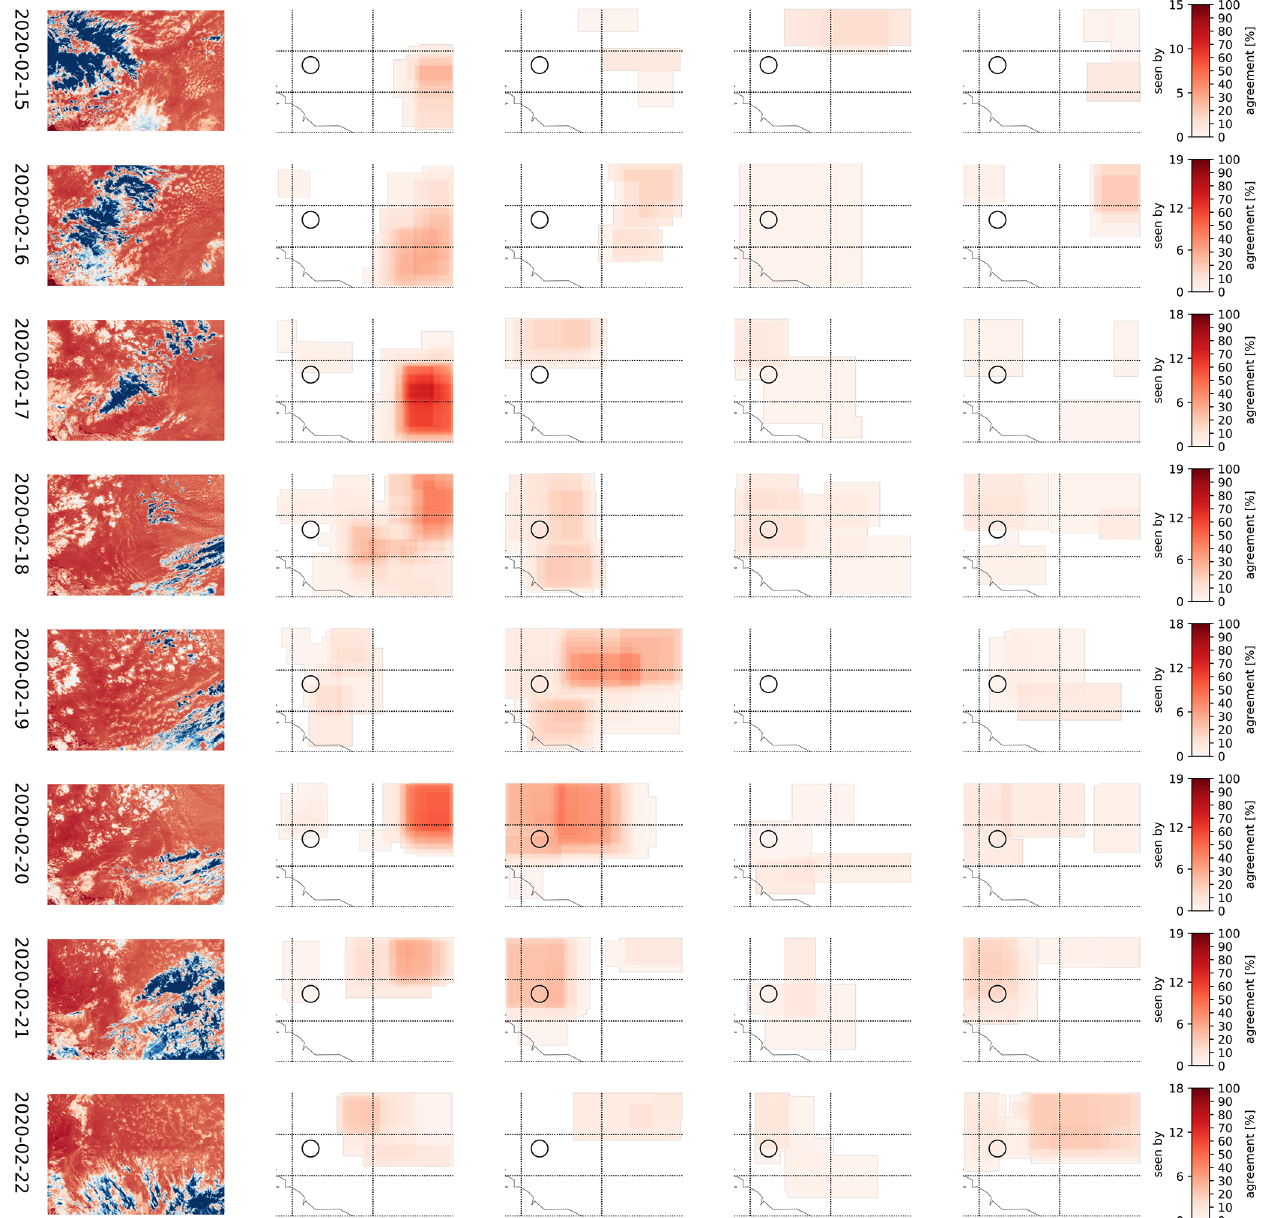
Figure A2. As Fig. A1 but for the infrared workflow. Images show the cloud field at 16:00 (except 11 February 2020 at 17:00). Please note that the date format in this figure is